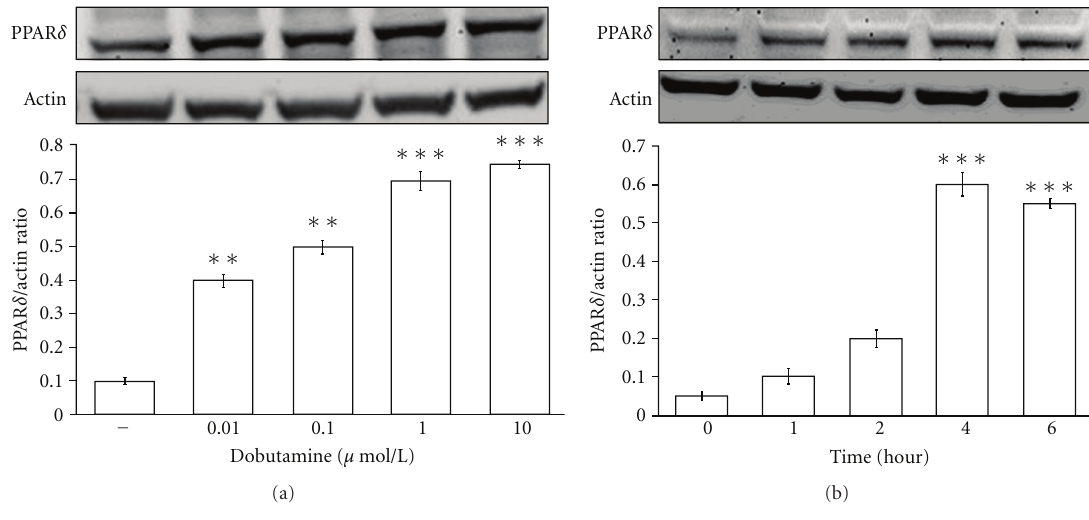
Figure 1: E ff ects of dobutamine on PPAR δ expression in neonatal rat cardiomyocytes . The neonatal rat cardiomyocytes were treated with dobutamine at various concentrations for 4hours (a) or at 1 μ mol/L during various time points (b). The treated cells were harvested to determine the protein levels by Western blotting analysis. All values are presented as mean ± SEM ( n = 6 per group). ∗ P < 0 . 05 and ∗∗ P < 0 . 01 as compared with the vehicle-treated control